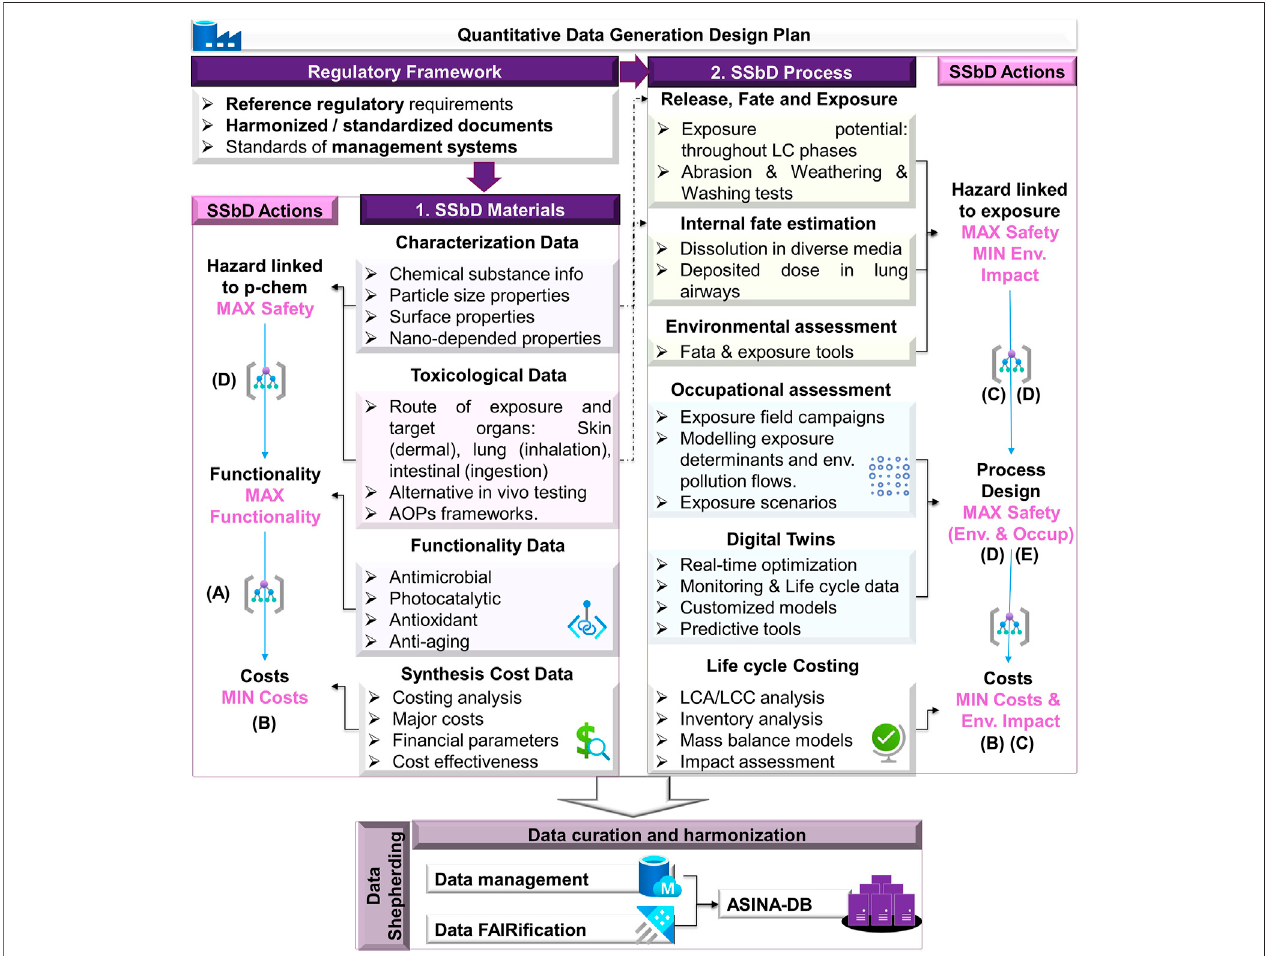
FIGURE 1| The ASINA-SMM data generation plan considering (A) functionality, (B) cost-effectiveness, (C) environmental sustainability, and (D) nano-safety while exploring digital technologies (E) .